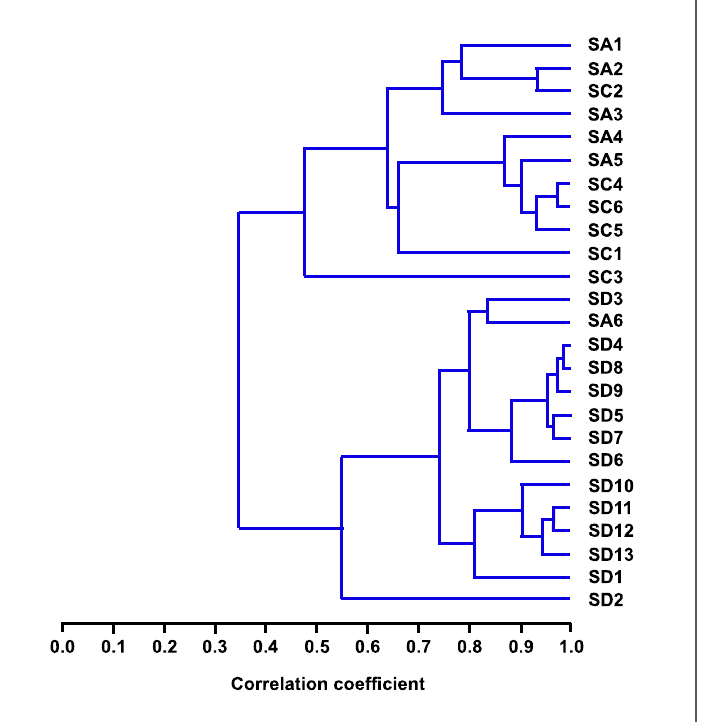
Figure 8. A dendrogram generated by cluster analysis of the percentage composition of essential oils from the three Salvia species studied, based on correlation and using the unweighted pair-group method with arithmetic average (UPGMA). SA = S. africana , SC = S. chamelaeagnea and SD = S. dentata .